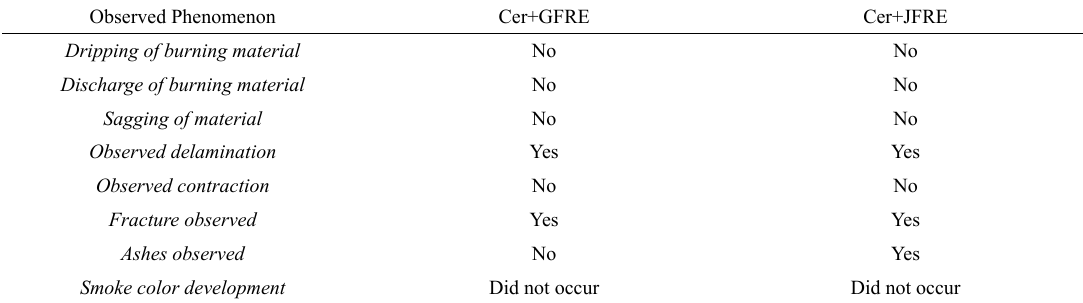
Table 3. Phenomena observed in the flame propagation test